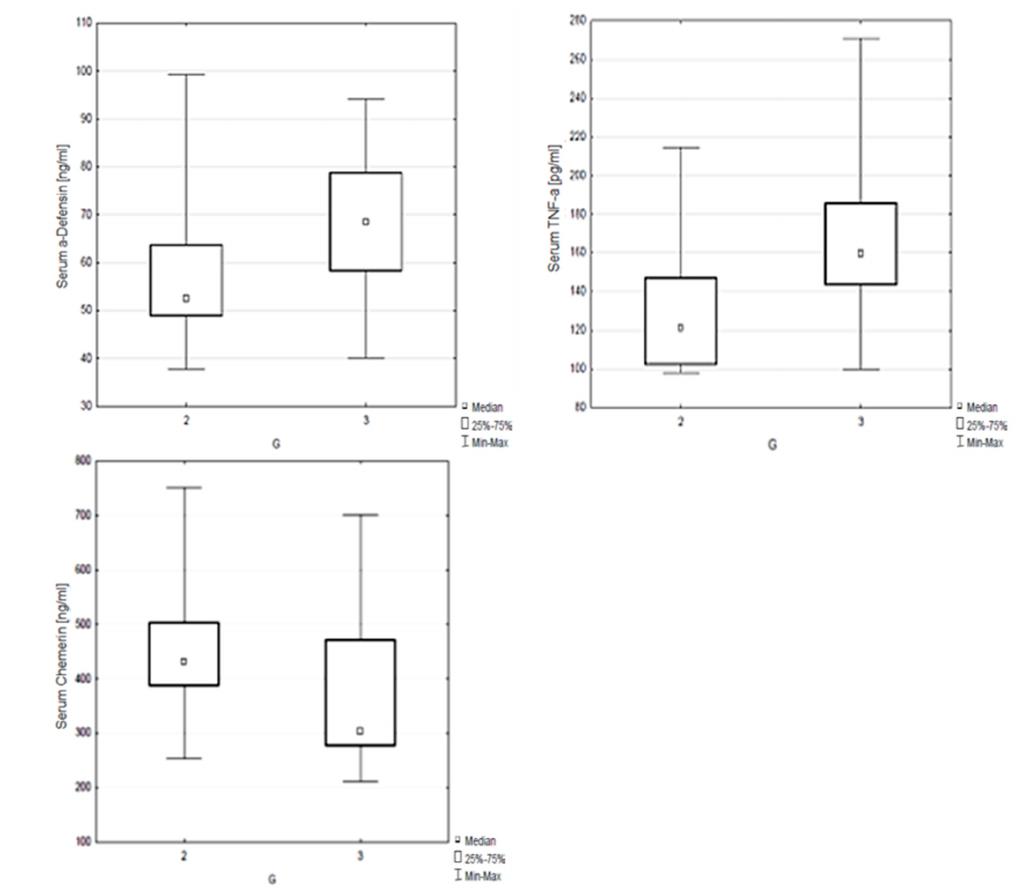
Figure 3. Correlation between serum concentrations of chemerin, α -defensin 1 and salivary concen- trations of TNF- α and the tumor grade.